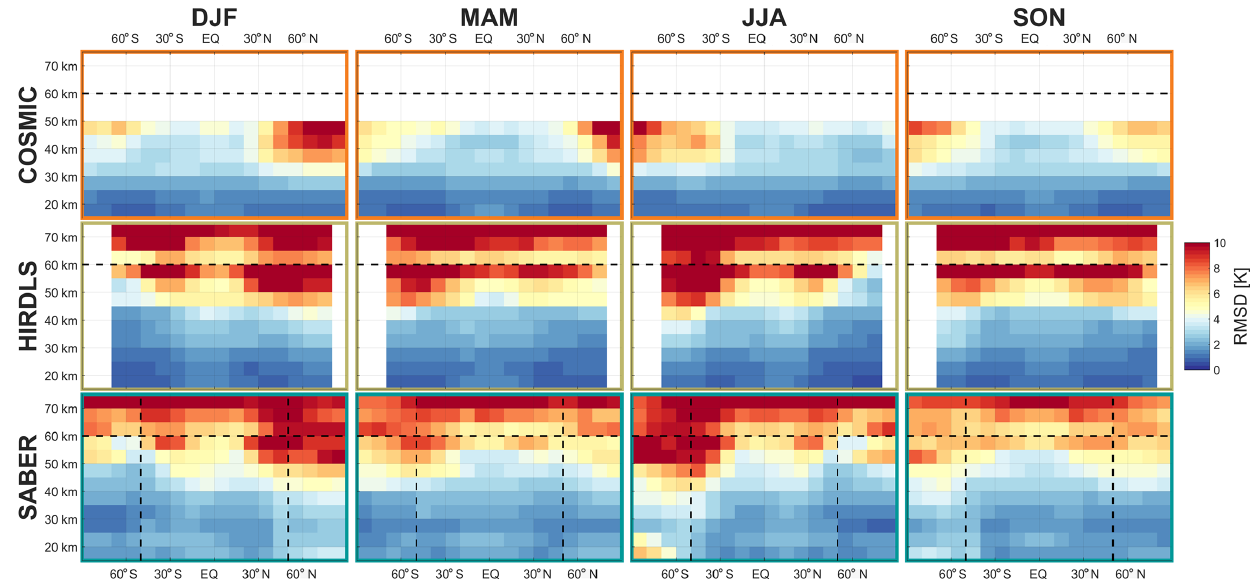
Figure 12. Root-mean-square differences between multi-reanalysis mean (MRM) sampled temperatures and each instrument, decomposed by latitude, altitude and season. Dashed line at 60km in altitude indicates the approximate height of the transition from a six-reanalysis MRM to a two-reanalysis MRM; dashed lines at 50 ◦ S and 50 ◦ N indicate the boundary of full and partial SABER coverage. See Supplement Figs. S7–S12 for individual satellite–reanalysis